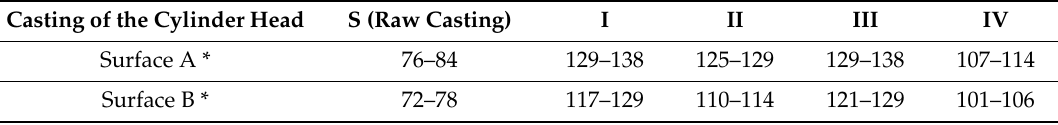
Table 3. HBS10 / 1000 / 30 hardness of the casting of the cylinder head. Table 3. HBS10/1000/30 hardness of the casting of the cylinder head.